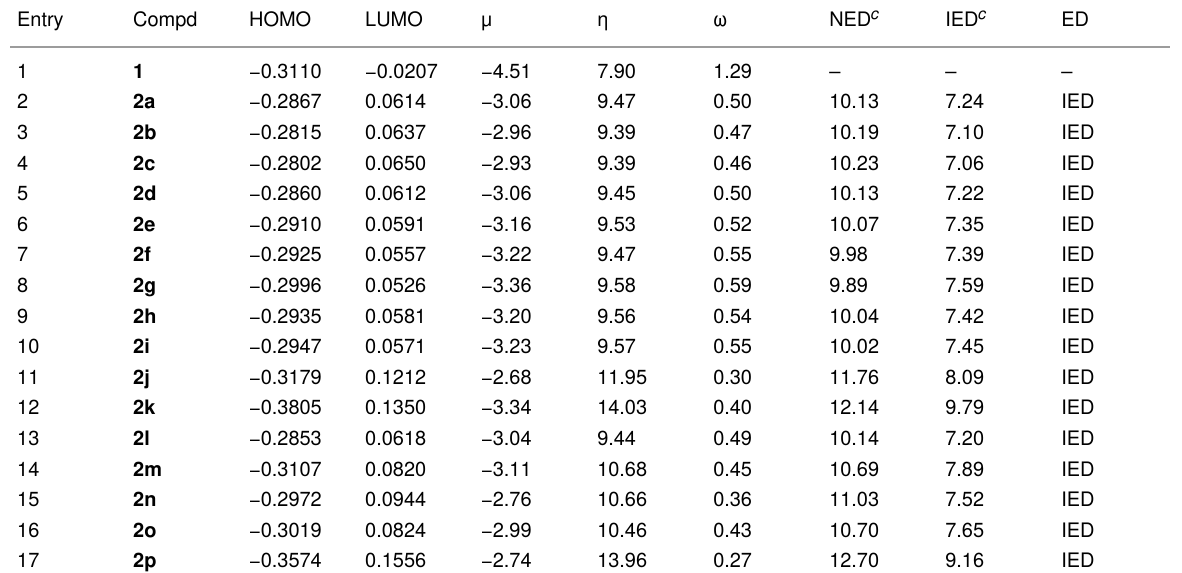
Table 2: FMO energies (a.u.), electronic chemical potential ( μ , eV), chemical hardness ( η , eV), and global electrophilicity index ( ω , eV) for PRP ( 1 ) and cyclopropenes 2 . a,b,c .